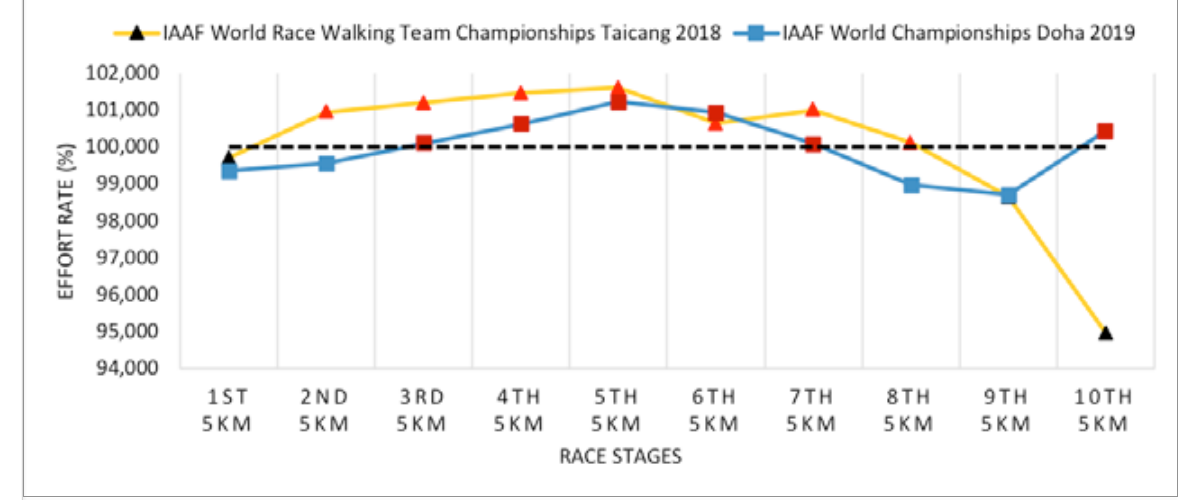
Figure 3 . Effort rate (%) of the stages of women’s 50km racewalking Table 3. Average Performance Time (sec), Average Speed (m/sec), and Effort Rate between the stages and final 50km (%) in both Championships.